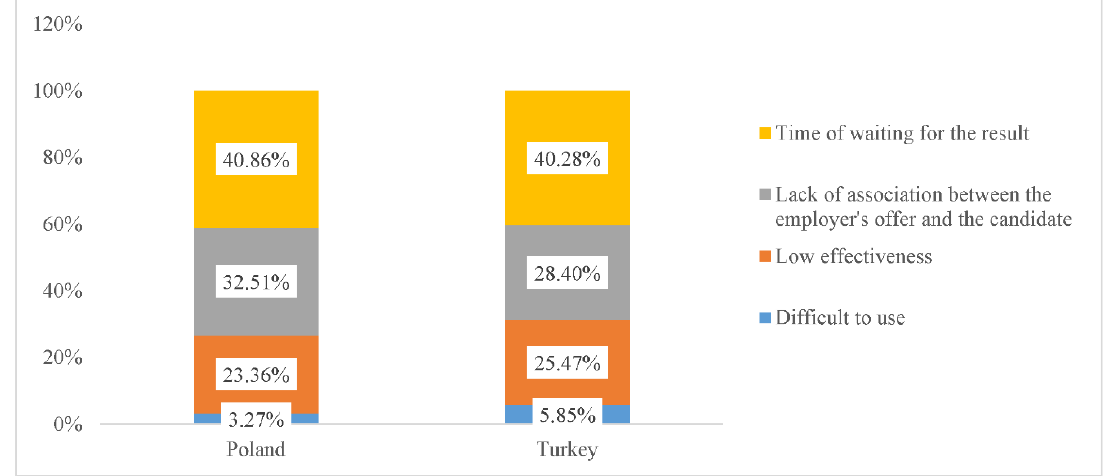
Figure 2. Disadvantages of HR portals in the opinions of respondents in Poland and Türkiye; Source: own work.